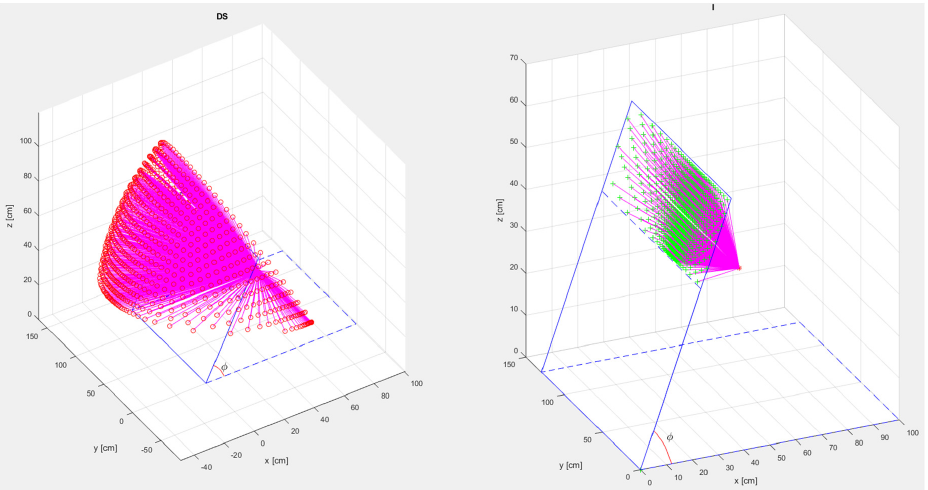
Figure 14. Test scenario 2—S is a mobile point and D is a fixed point.